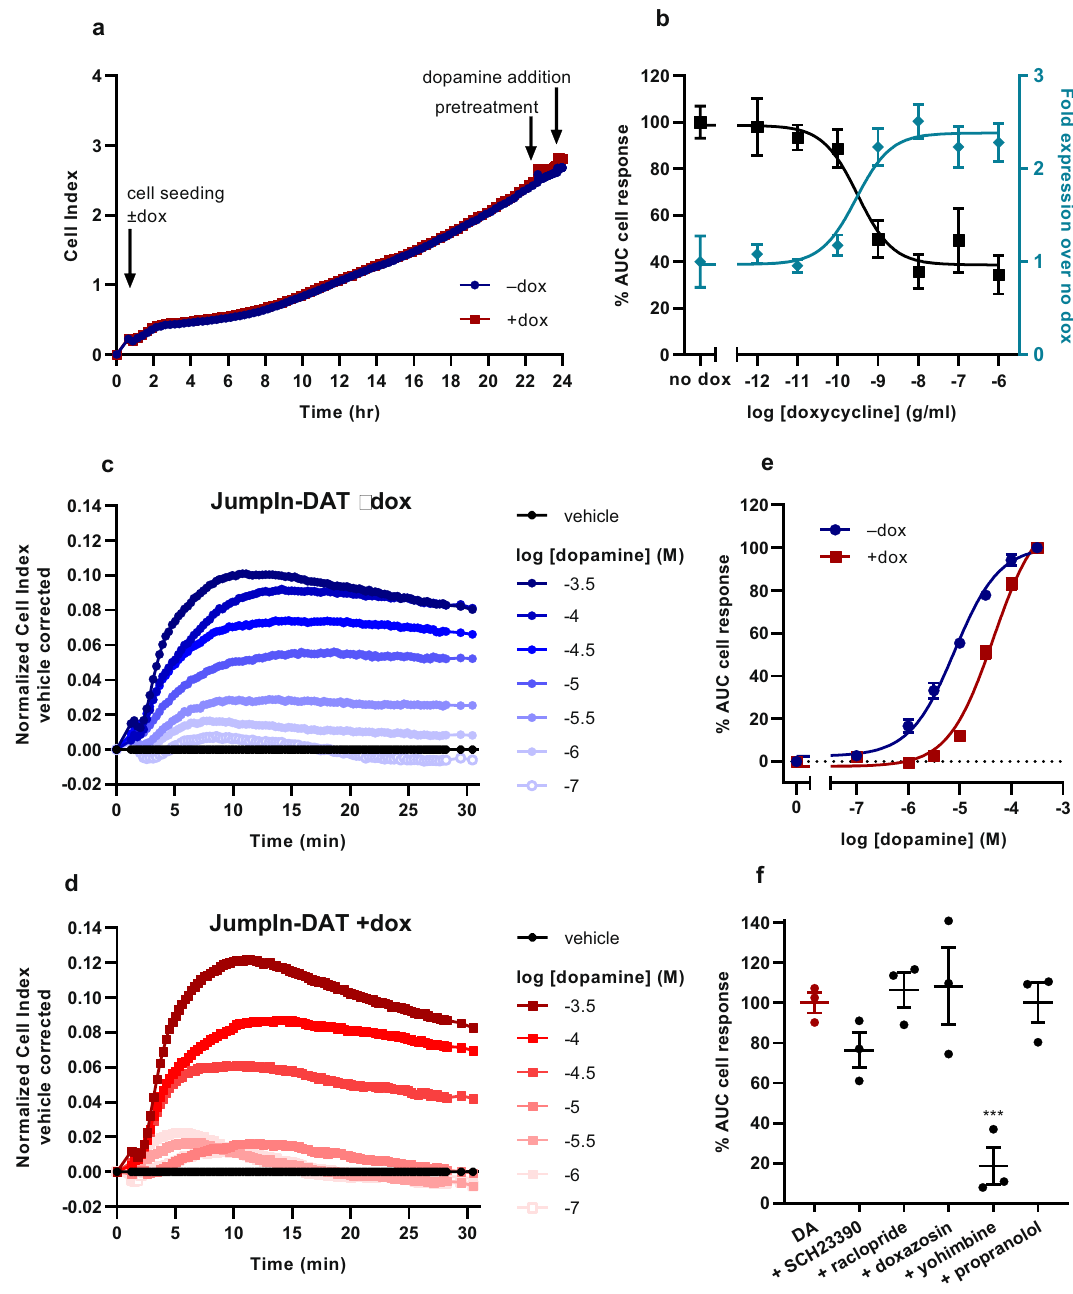
Figure 4. Functional characterization of dopamine (DA) response in JumpIn-DAT cells. ( a ) Representative xCELLigence growth curves after cell seeding ± 1 µg/ml dox, inhibitor pretreatment and dopamine addition. ( b ) Effect of dox on JumpIn-DAT cell response (TRACT assay) upon stimulation with 10 µM dopamine (set at 100%) ( ■ ) and effect of dox on cell surface expression of DAT detected by HA-tag ELISA (teal ♦ , expressed as fold over mock). Data are shown as mean ± SD (HA-tag ELISA) or SEM (TRACT assay) of two or three separate experiments performed in quintuplicate or duplicate, respectively. ( c ) Representative vehicle- corrected xCELLigence traces of JumpIn-DAT cells in the absence of dox (–dox) and ( d ) JumpIn-DAT cells in the presence of 1 µg/ml dox (+dox) after stimulation with increasing concentrations of dopamine. Data is normalized prior to agonist addition at time = 0 min. ( e ) Concentration-effect curves of dopamine on JumpIn- DAT cells ± dox are shown as the net AUC of the first 30 min after stimulation normalized to the cell response of 316 µM dopamine. ( f ) Cell response of 31.6 µM dopamine (red bar, set at 100%) on dox-treated JumpIn- DAT cells pretreated for 1 h with 1 µM of one of following GPCR antagonists: SCH23390 (dopamine D 1 -like), raclopride (dopamine D 2 -like), doxazosin (alpha-1 adrenergic), yohimbine (alpha-2 adrenergic), propranolol (beta adrenergic). Data are shown as mean ± SEM of three to nine individual experiments each performed in duplicate. Comparison of multiple mean values to vehicle control was done using a one-way ANOVA with Dunnett’s post-hoc test. ***p <